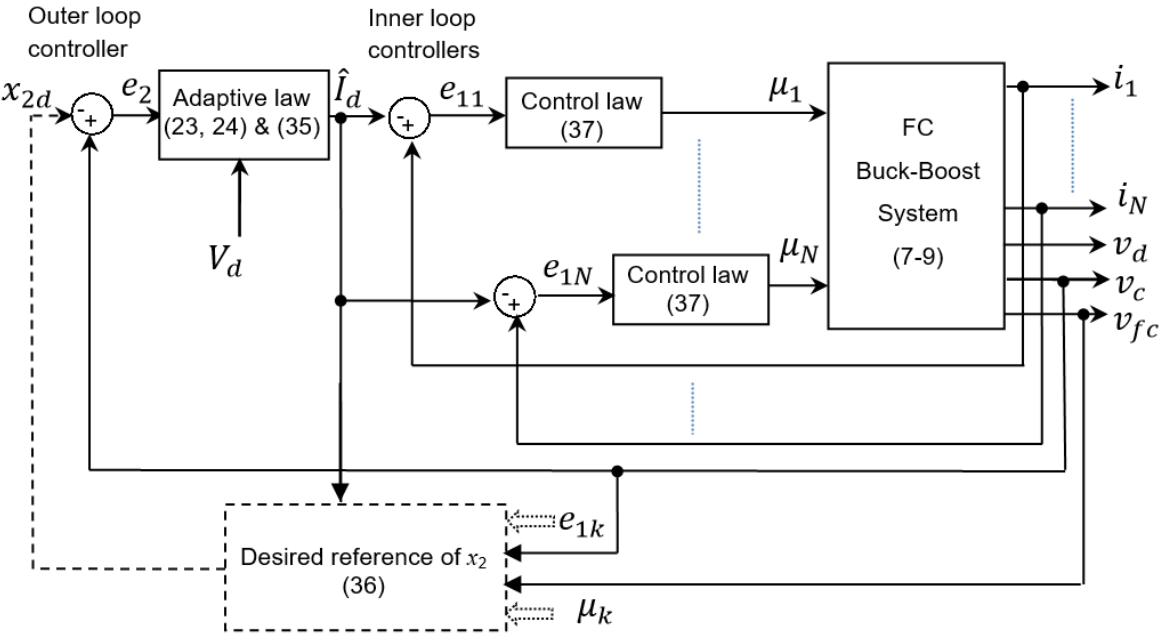
Figure 5. Nonlinear cascade control architecture.